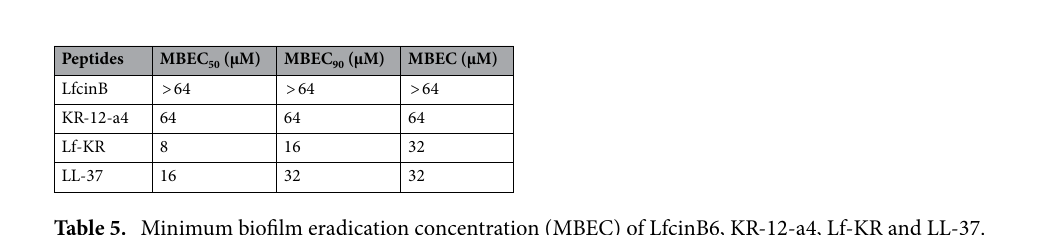
Table 5. Minimum biofilm eradication concentration (MBEC) of LfcinB6, KR-12-a4, Lf-KR and LL-37.